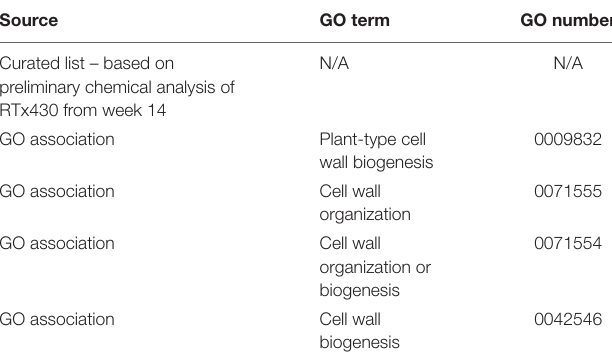
TABLE 1 | Sources of cell-wall related highly variable genes (HVGs) analyzed in this study. Source GO term GO